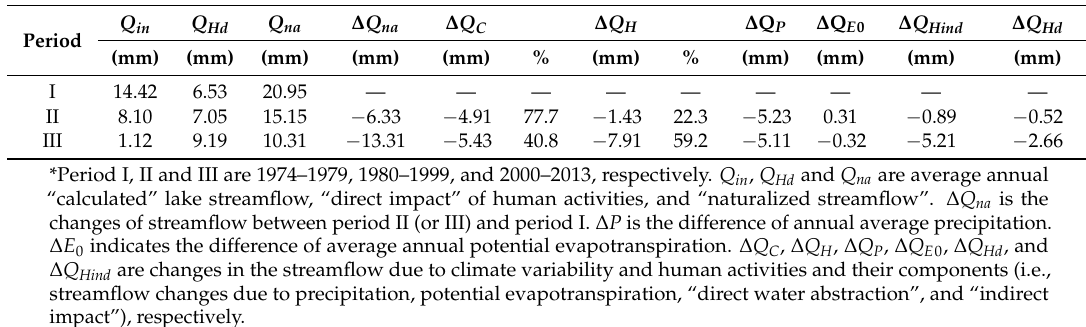
Table 2. Impacts of climate change and human activities on streamflow in the Bojiang Lake basin estimated by the climate elasticity method